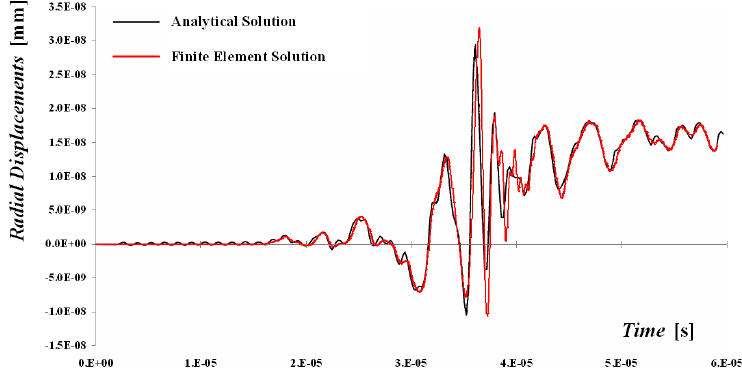
Figura 1: Confronto tra la soluzione analitica e quella agli elementi